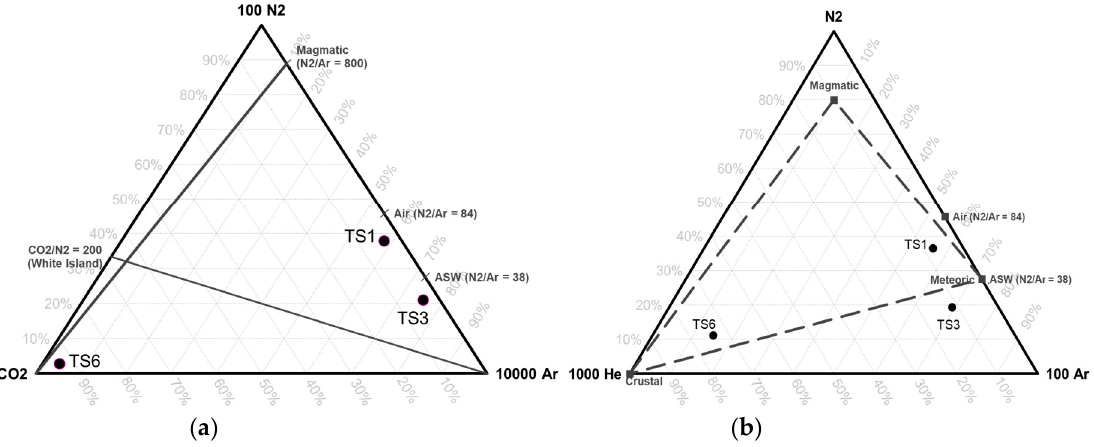
Figure 11. ( a ) The results of the N 2 –CO 2 –Ar diagram show the origin of hydrothermal fluid from meteoric water. ( b ) The same result is also found from the analysis of the N 2 –He–Ar diagram.